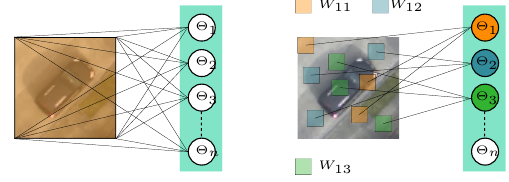
Figure 2. On the left a fully connected layer is depicted, each neuron is connected to every value of the input data. On the right side a locally connected layer is shown, each neuron is connected to a receptive field and the weights of each neuron are shared for every sampling position of the